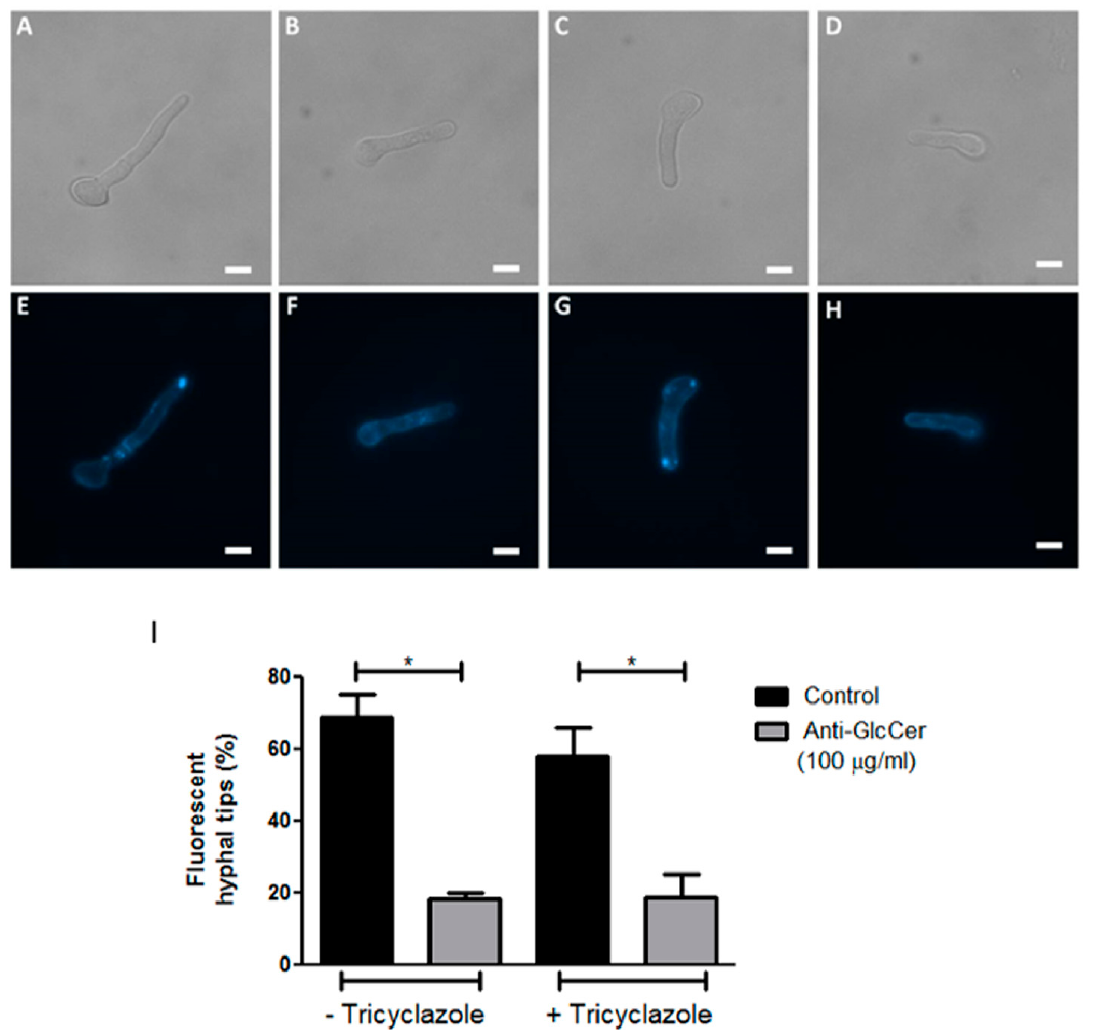
Figure 4. Organization of lipid rafts in S. aurantiacum WM 06.385 after 3 h of germination. Filipin staining was performed in untreated ( E , F ) and tricyclazole-treated ( G , H ) conidia, in the absence ( E , G ) or presence of anti-GlcCer (100 µg/mL) ( F , H ). In ( A–D ) differential interferential contrast microscopy is presented. Scale bar: 5 µm. The graph in ( I ) represents the quantification of cells that displayed fluorescent hyphal tips. * p < 0.05.